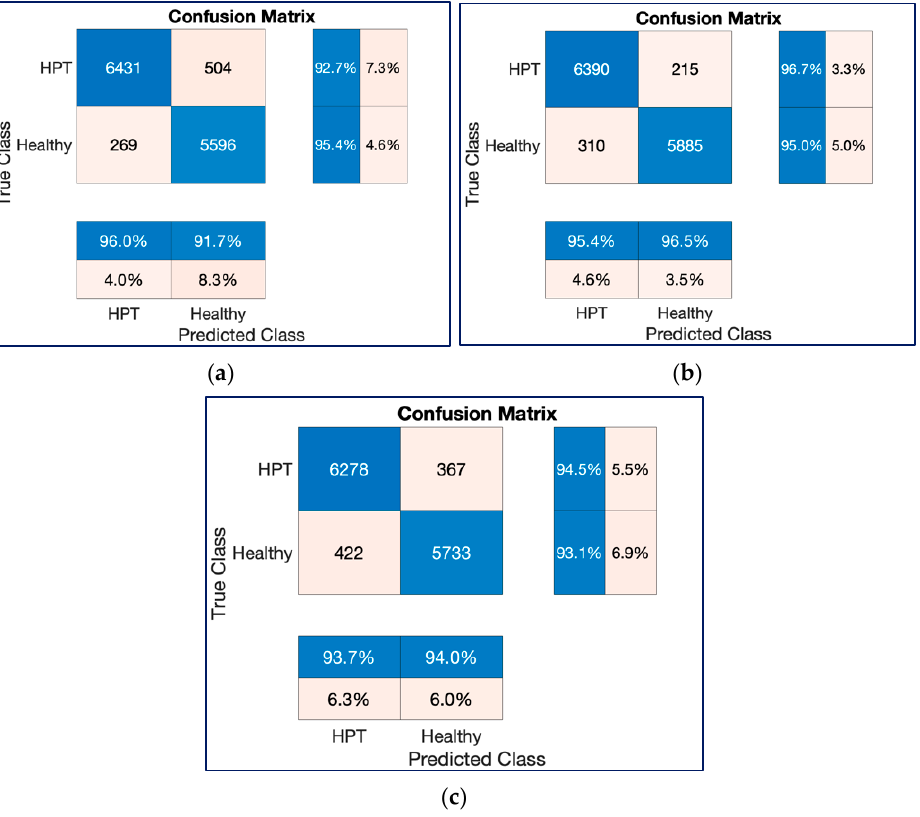
Figure 14. Cumulative confusion chart results for classification processes with 12,800 spectrogram images on the 10 ‐ FCV. ( a ) ResNet18, ( b ) ResNet50, ( c ) ConvMixer.